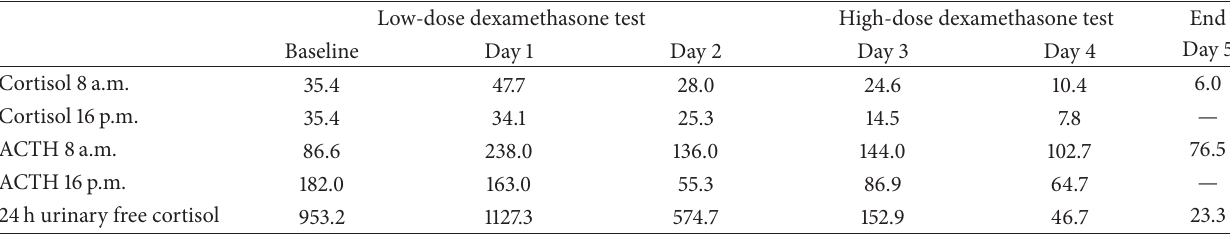
Table 2: Low- and high-dose dexamethasone suppression tests.